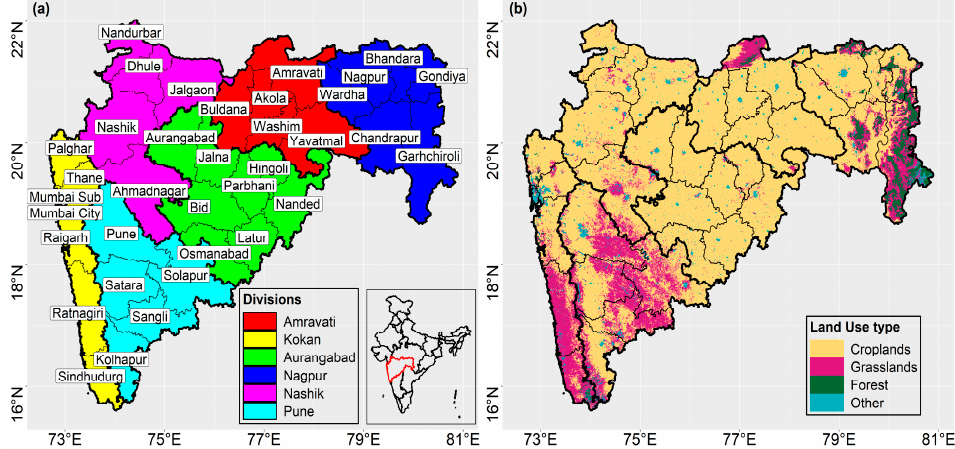
Figure 1. ( a ) Six administrative divisions of the Maharashtra state. ( b ) International Geosphere-Biosphere Program (IGBP) land-use classification.